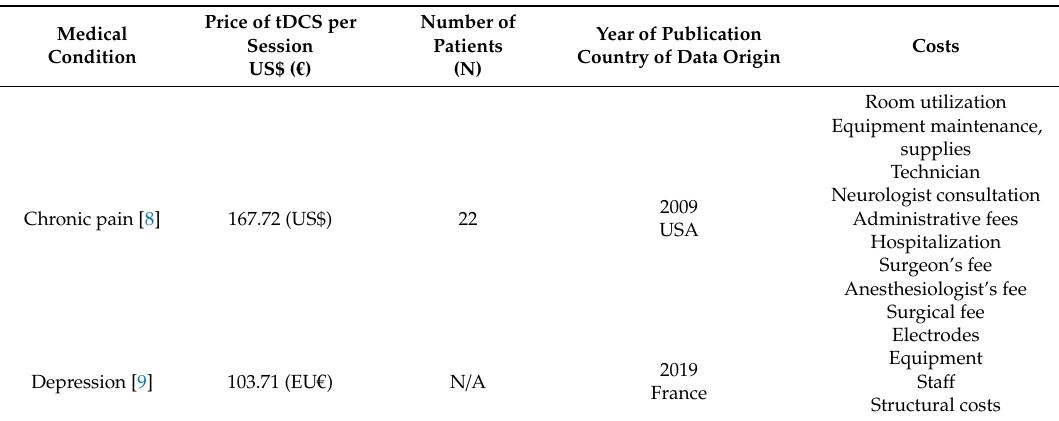
Table 3. Published data on the use and cost of transcranial direct current stimulation (tDCS) for treatment of chronic medical conditions. Data are available only on tDCS for chronic pain (Zaghi et al., 2009) [8] and depression (Sauvaget et al., 2019) [9].